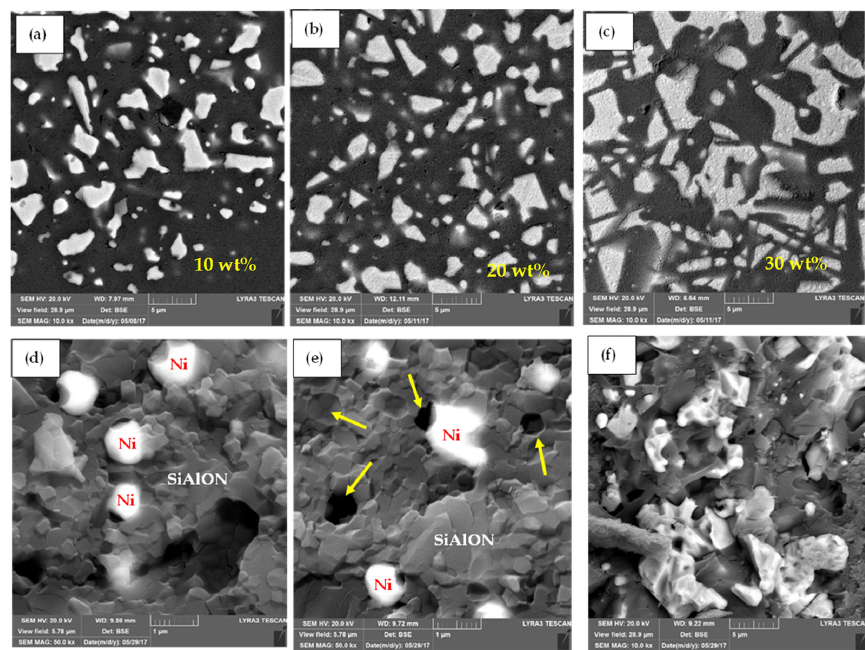
Figure 7. Polished FESEM images ( a – c ) of the Ca- α -SiAlON composites with 10 wt.%, 20 wt.%, and 30 wt.% Ni compositions, respectively (the black area shows the SiAlON matrix, and the bright dispersed phase is Ni). FESEM images ( d – f ) of the fracture surface morphology of the Ca- α -SiAlON composites with 10 wt.%, 20 wt.%, and 30 wt.% Ni compositions, respectively. The arrows in the figures show the voids that appeared due to the pullout of Ni particles during sample